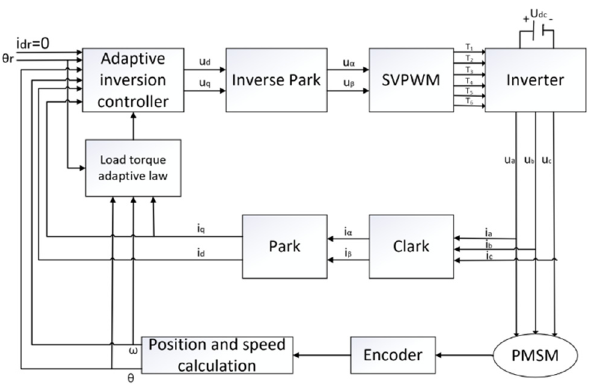
Figure 2. Block diagram of adaptive inversion control system for PMSM.